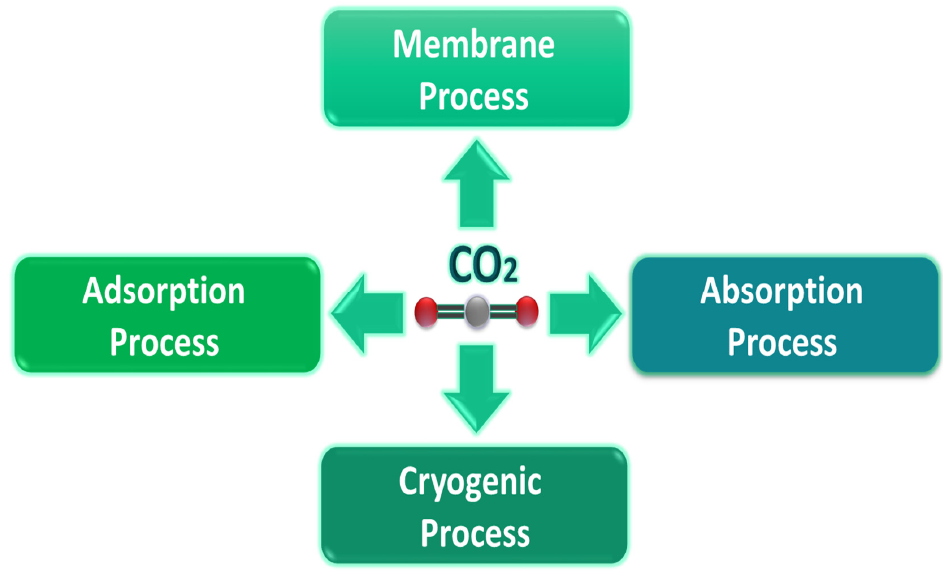
Figure 1. Post-combustion carbon dioxide capture processes. Figure 1. Post ‐ combustion carbon dioxide capture processes.